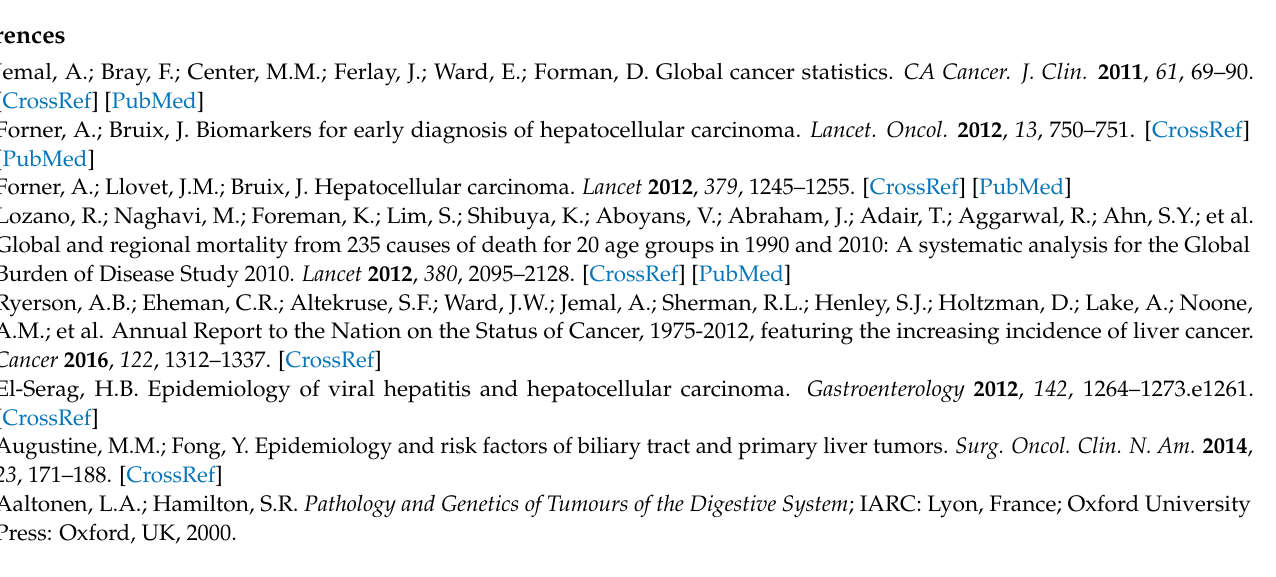
Table S1. Conflicts of Interest: The authors declare no conflict of